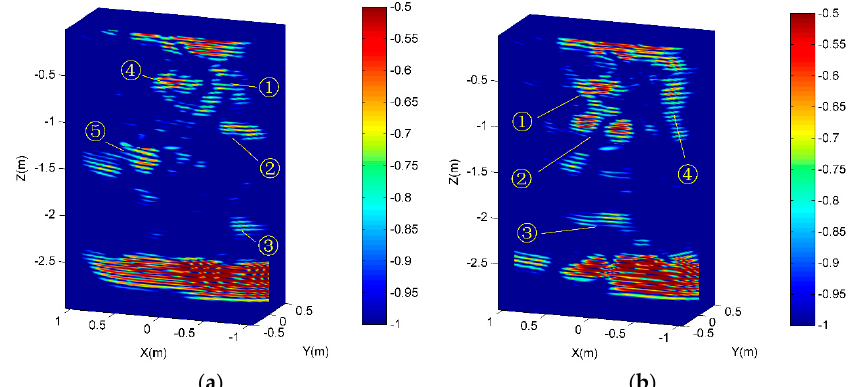
Figure 8. RTM results for the Chang’E-5 UWBR system experimental data based on the DZT-ME-SO-PML method, ( a ) for Figure 5a, and ( b ) for Figure 5b, respectively.